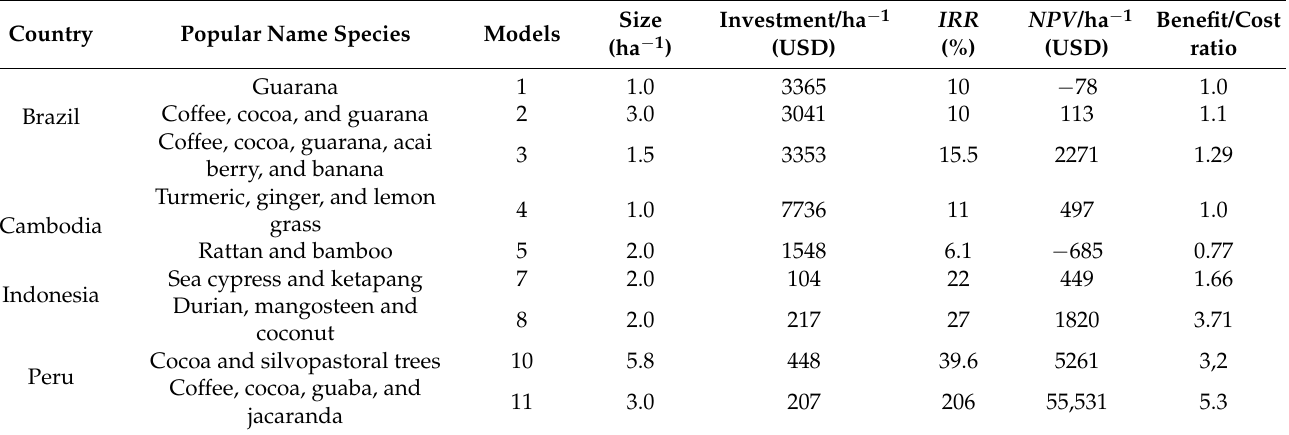
Table 5. Financial indicators generated from investment costs to restore tropical forests in four countries in 2018 and